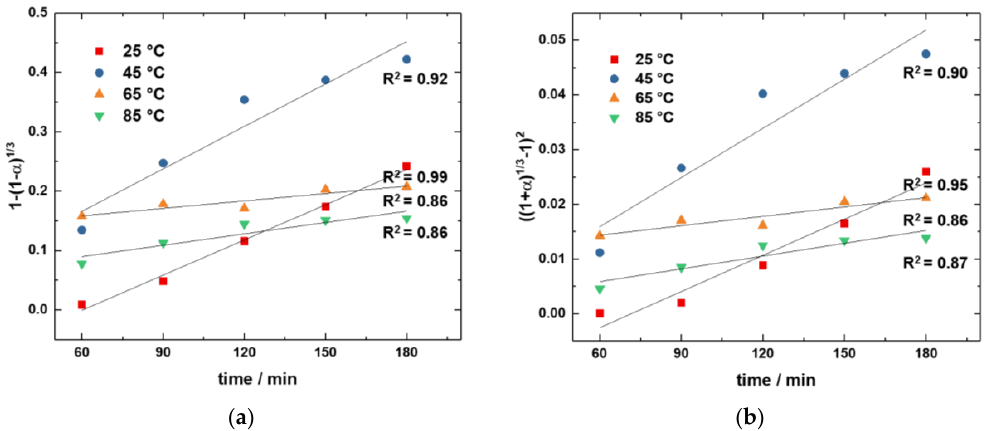
Figure 6. The relationship between ( a ) 1 − (1 − α) 1/3 (reaction-controlled) and ( b ) ((1 + α) 1/3 − 1) 2 (diffusion-controlled) and the time for silver leaching at various temperatures.